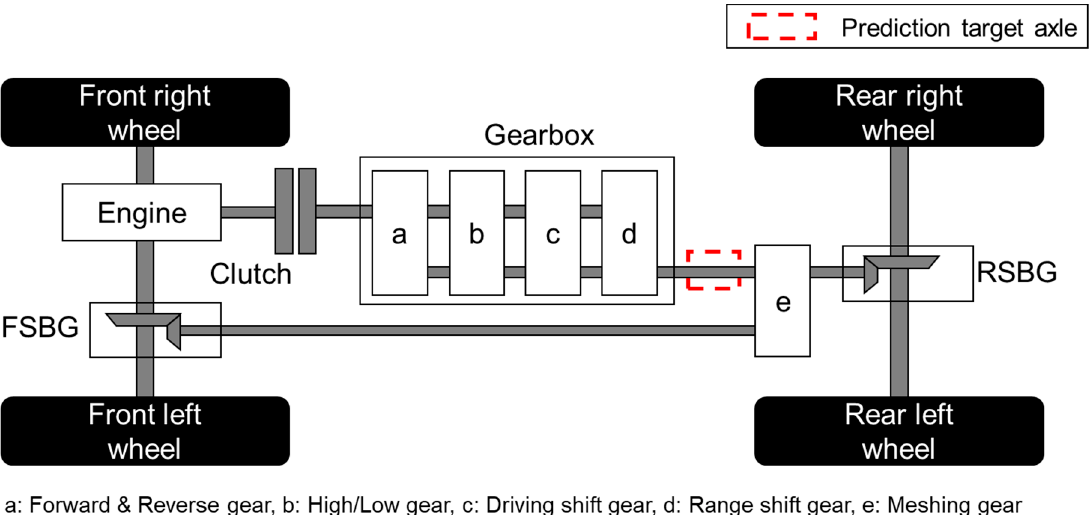
Figure 1. Schematic diagram of a tractor power transmission system with prediction target axles.